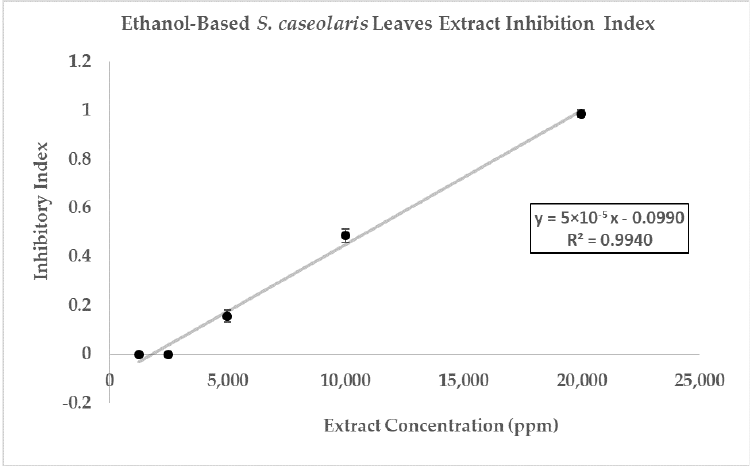
Figure 4. Antibacterial activity of ethanol-based S. caseolaris leaves extract against MRSA strain. Positive control was made from Vancomycin (5 μg), yielding a ZOI diameter of 24 ± 0.1 mm.